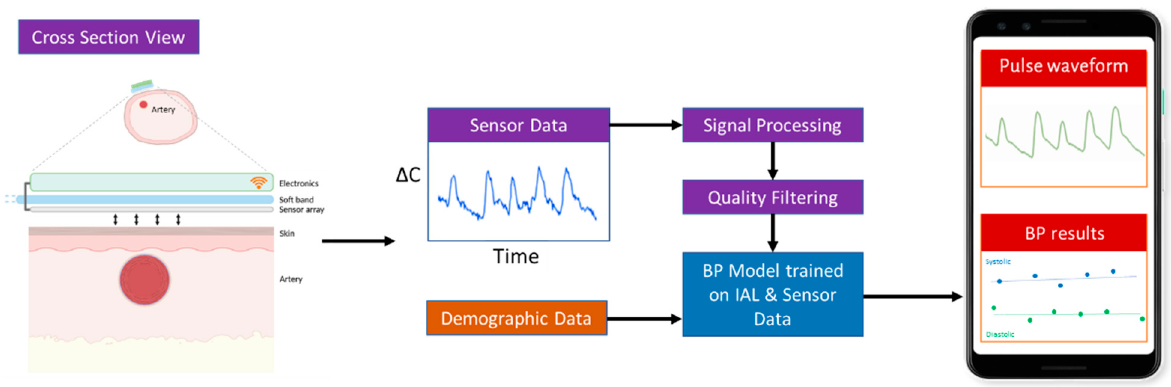
Figure 2. Overview of the working of the sensor and steps to infer blood pressure.